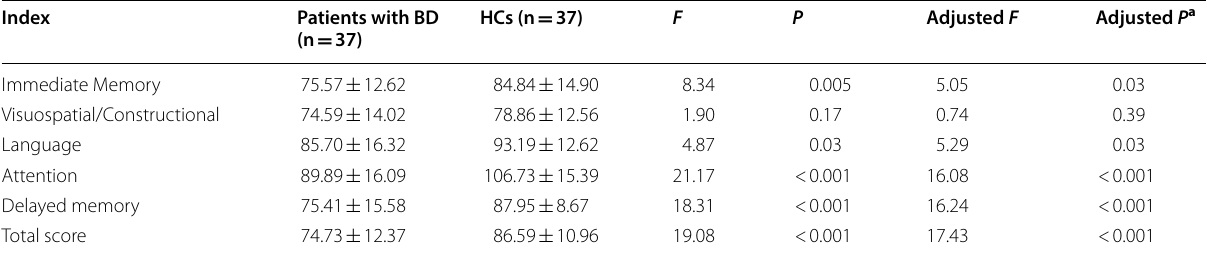
a Adjusted F indicated the F value after controlling for gender, age, education, BMI and serum HDL levels